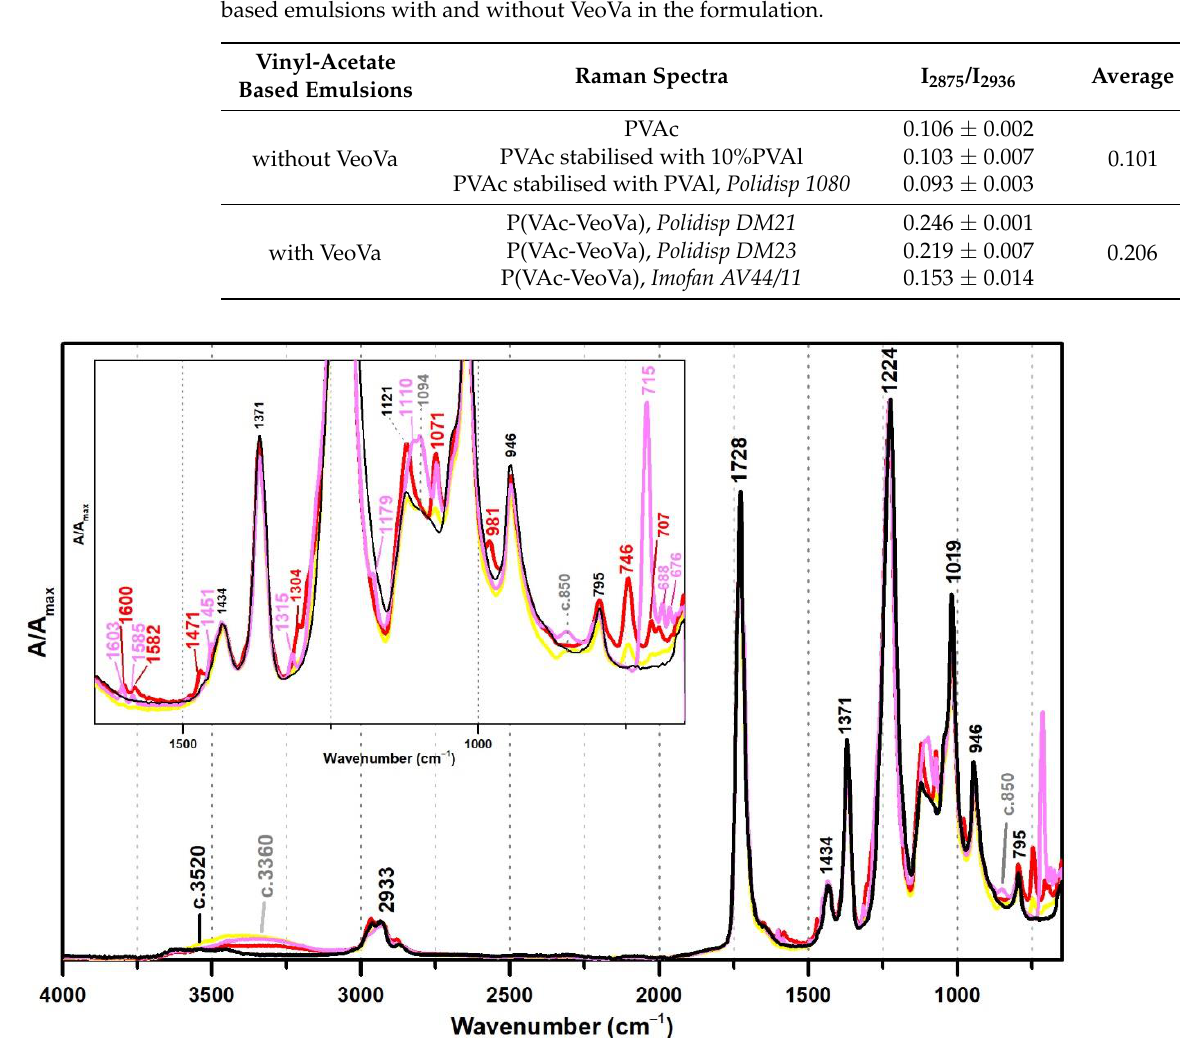
Table 2. Raman intensity ratios for the symmetric and antisymmetric CH 2 bonds in vinyl-acetate based emulsions with and without VeoVa in the formulation.